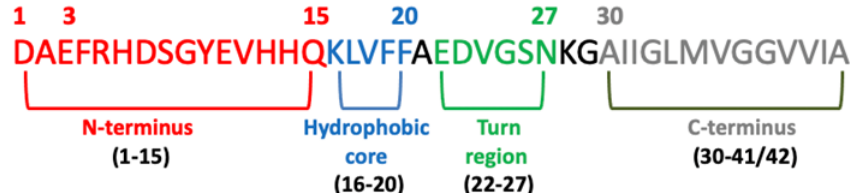
Figure 4. Schematic view of the Abeta domains.